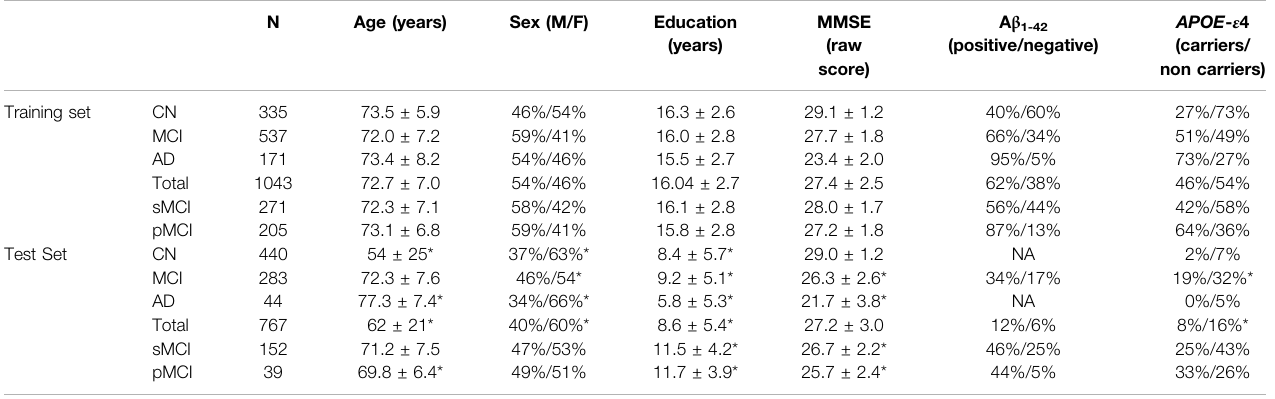
TABLE 2 | Demographic, clinical, genetic and biological characteristics of the training and test